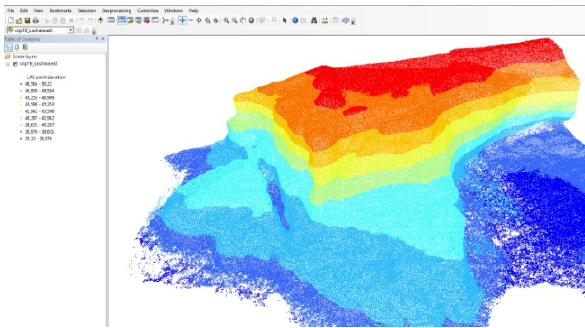
Figure 6: LAS point cloud imported in ArcGis with 9 classes of elevation.